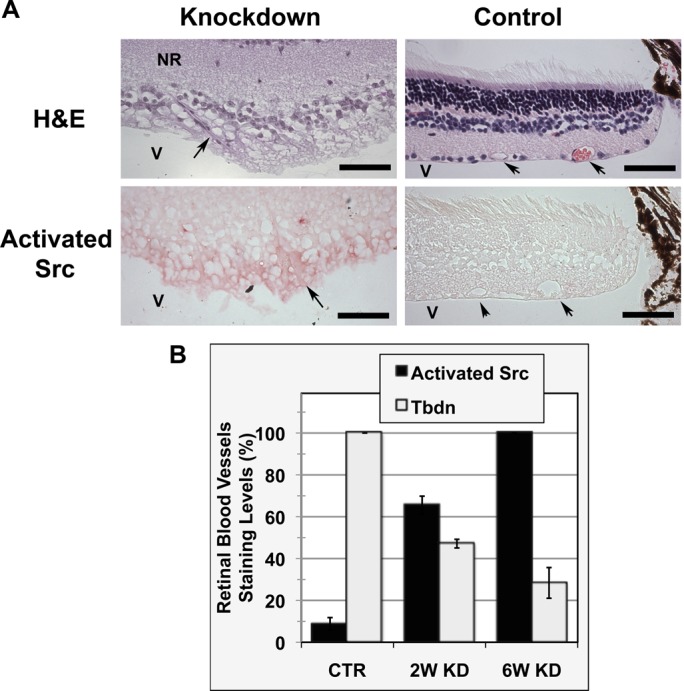
Levels of activated Src family of kinases in retinal lesions of Tbdn knockdown mice. (A) Top panels, hematoxylin/eosin (H&E) staining of eye sections from a 6 week-induced endothelial specific Tbdn knockdown mouse retinal lesion showing abnormal blood vessels and retinal thickening compared to a control age-match mouse retina section. Lower panels, immunohistochemical analysis of the levels of activated SFK (shown by red staining) of specimens shown in top panel. Retinal sections stained with no primary antibody showed no staining (not shown). All images are oriented with the vitreous cavity (v) of the eye at the bottom of the panels, blood vessels arrowed, NR: neural retina. 400×, scale bar=50 µm. Representative experiment is shown. (B) Quantitation of levels of Tbdn and activated SFK in retinal blood vessels of lesions from 2-week (2W) and 6-week (6W) induced Tbdn knockdown (KD) compared to normal retinal blood vessels of age-matched control (CTR). Data shown in B is expressed as mean±s.e.m. of at least 3 duplicate experiments in each group.